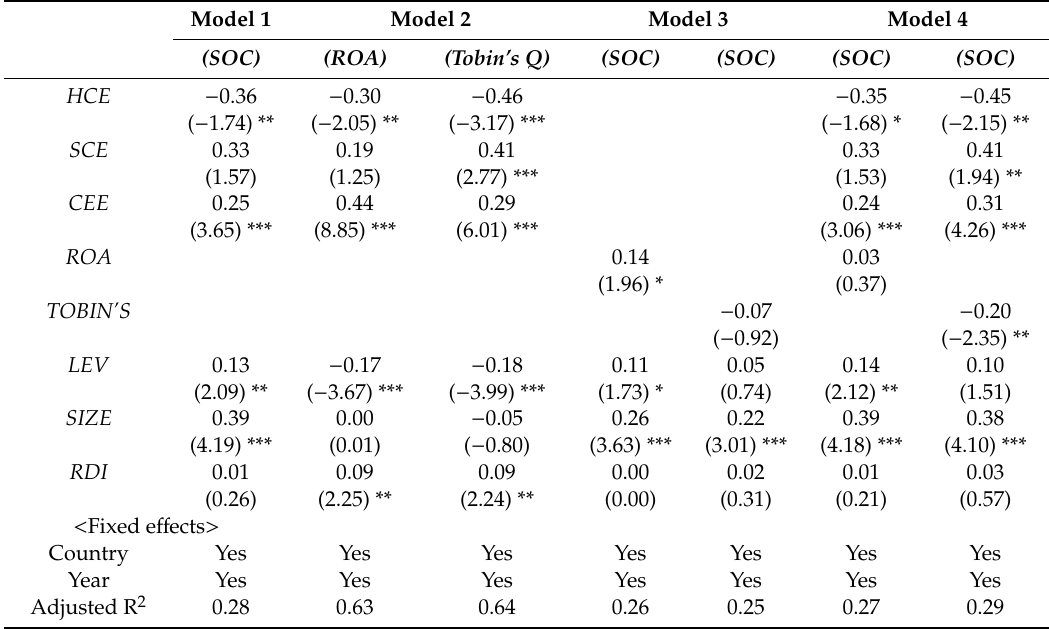
Table 4. Mediating e ff ect of financial performance (IC and